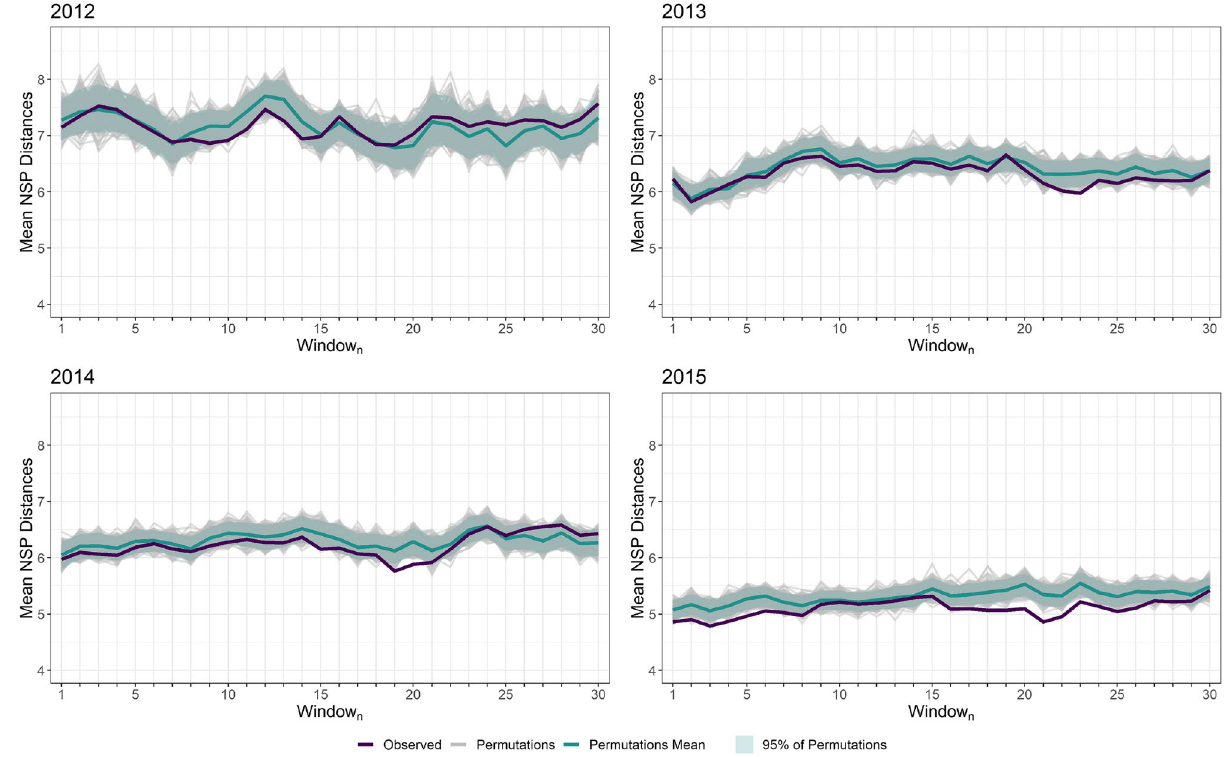
Figure 5. Sensitivity analysis on the impact of the time window chosen to look for candidate transmitters: mean network distances between incident episodes and their closest potential infectors obtained for sliding 1-week time windows, 2012–2015. For each year, the mean network distance is plotted as a function of the first day of the 1-week time window, Window n , for observed data and permuted data. For the permutations, 95% bands are also